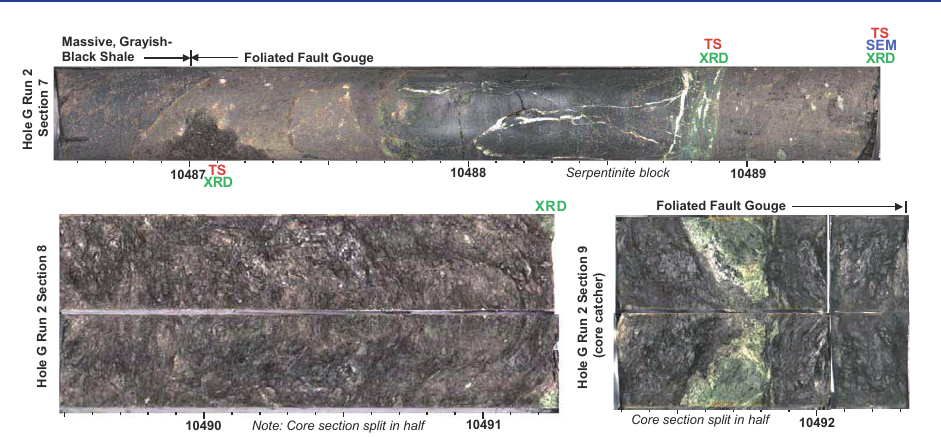
Figure 6. Photographs of the section of core 2 that crosses the SDZ (see Figs. 4 and 5) as they appear in the Photographic Atlas of the SAFOD Phase 3 (Table 1). The colored lettering indicates where samples were used for TS, XRD, and SEM presented in the Phase 3 Core Atlas. Note that the center and bottom photos are of the core sections split in half. Measured depths (in the sidetrack) are shown in feet (1 ft=30.48